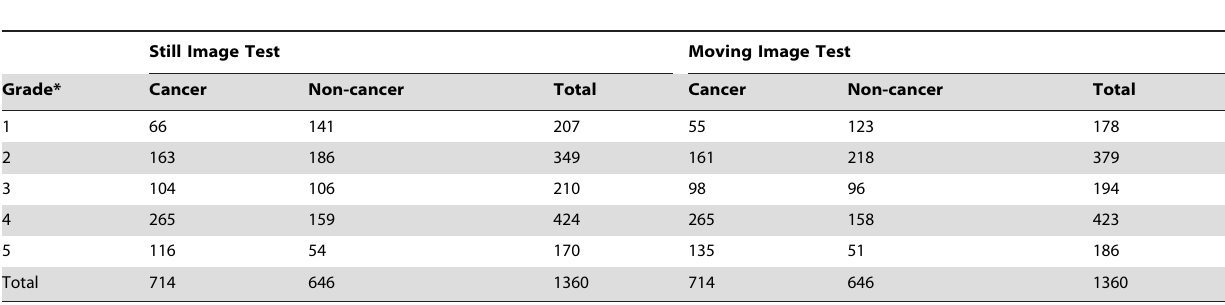
Table 4. Endoscopic Diagnoses for All Lesions according to Grade of Certainty in Still and Moving Image Tests.